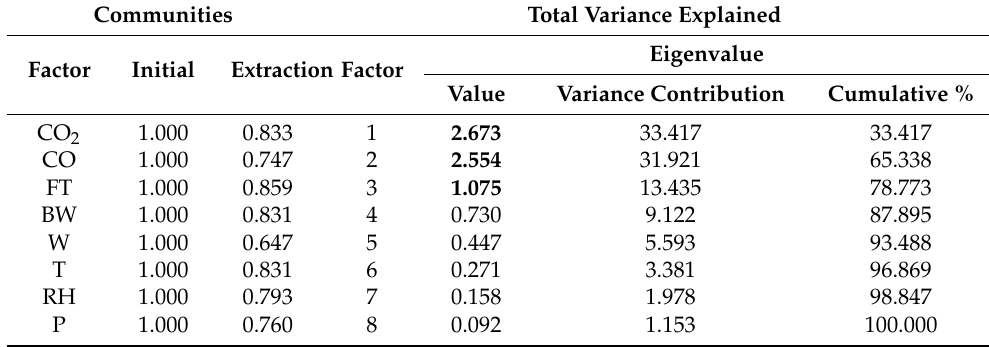
Table 2. Factor loading matrix of GPCA.